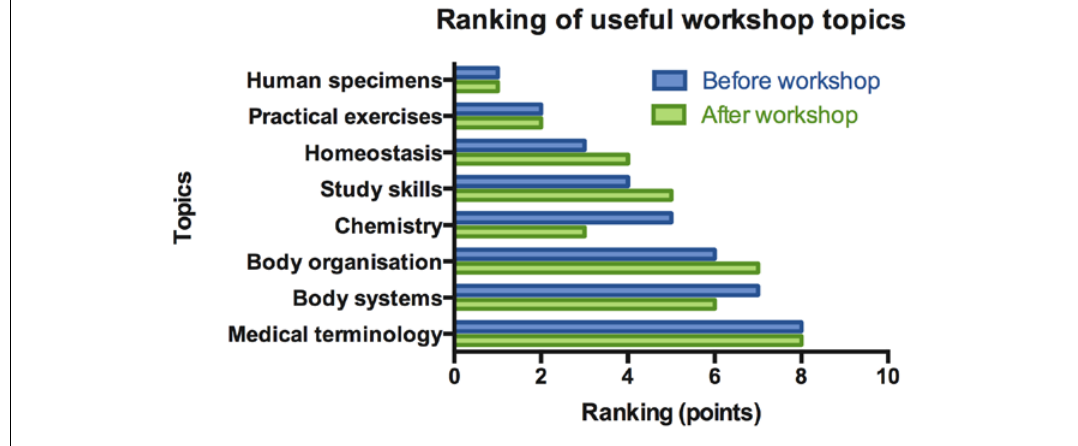
Figure 2: Ranking of topics for usefulness